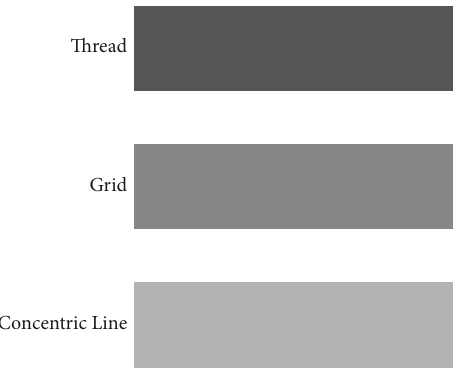
Figure 6: Fill pattern